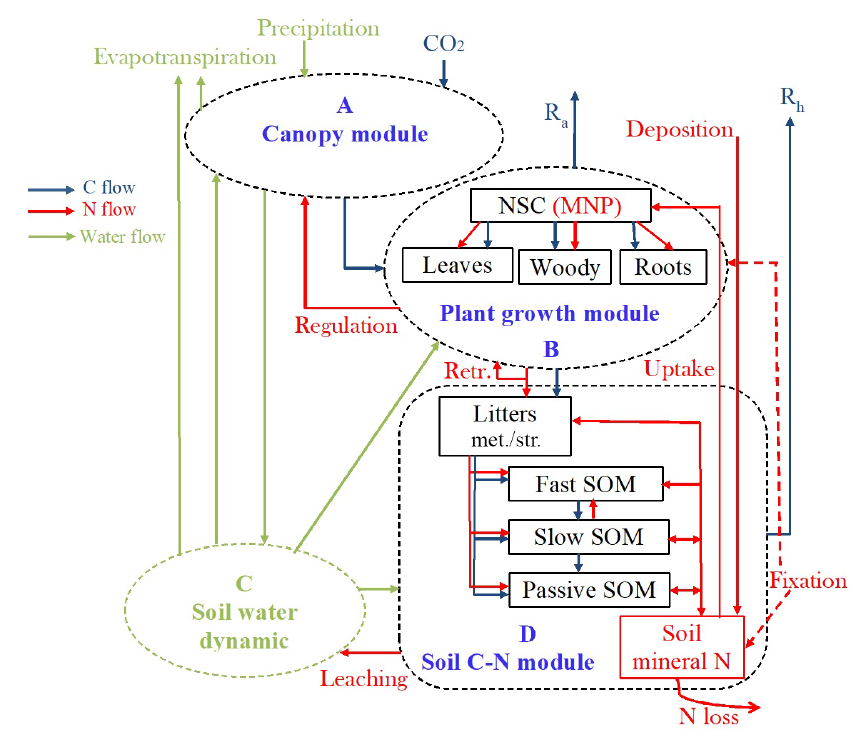
Figure 1. Schematic diagram of the terrestrial ecosystem carbon (C) and nitrogen (N) coupling model (TECO-CN). (A) Canopy module, (B) plant growth module, (C) soil water dynamics module, and (D) soil carbon–nitrogen coupling module. Rectangles represent the carbon and nitrogen pools. R a is autotrophic respiration. R h is heterotrophic respiration. Retr.: retranslocation. NSC: nonstructural carbohydrate. MNP: mineral N in plant tissues. SOM: soil organic matter. ∗ Set N fixation as an option when the plant N uptake is not enough for growth in terms of C